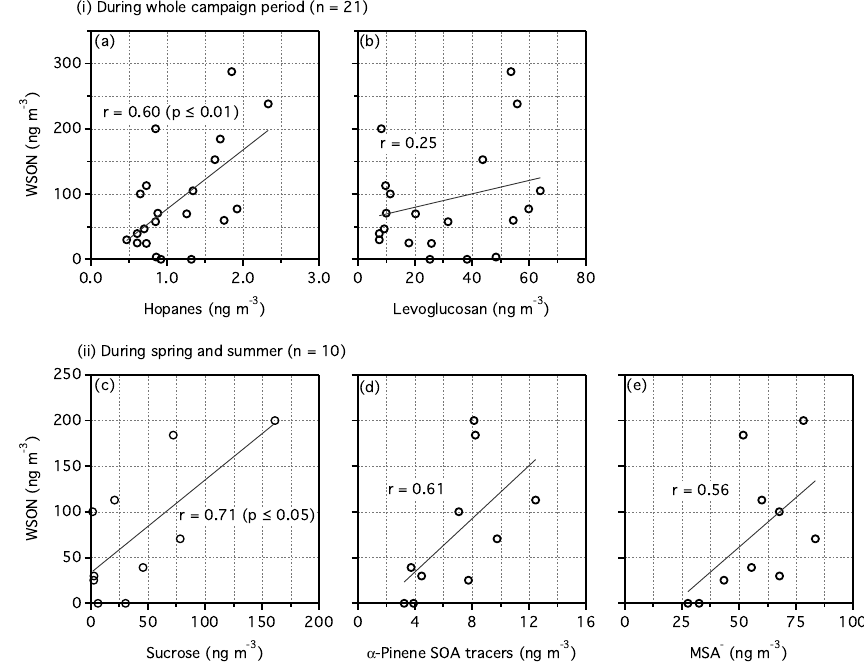
Figure 5. Linear relations of WSON with (a) hopanes (C 27 –C 32 hopanoid hydrocarbons) and (b) levoglucosan during the campaign period ( n = 21) and with (c) sucrose, (d) α -pinene-SOA tracers (sum of 3-hydroxyglutaric, pinonic, pinic and 3-methyl-1,2,3-butanetricarboxylic acids), and (e) MSA − in spring and summer ( n = 10) in Sapporo